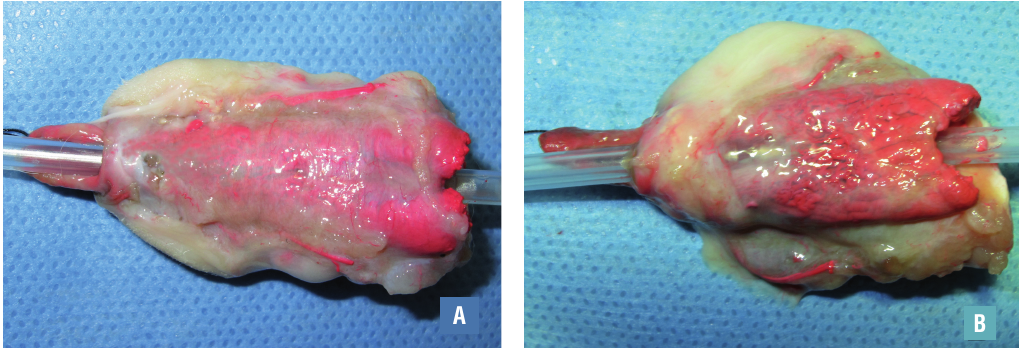
Figure 3 - Corpus spongiosum of experimental (A) and control group (B).